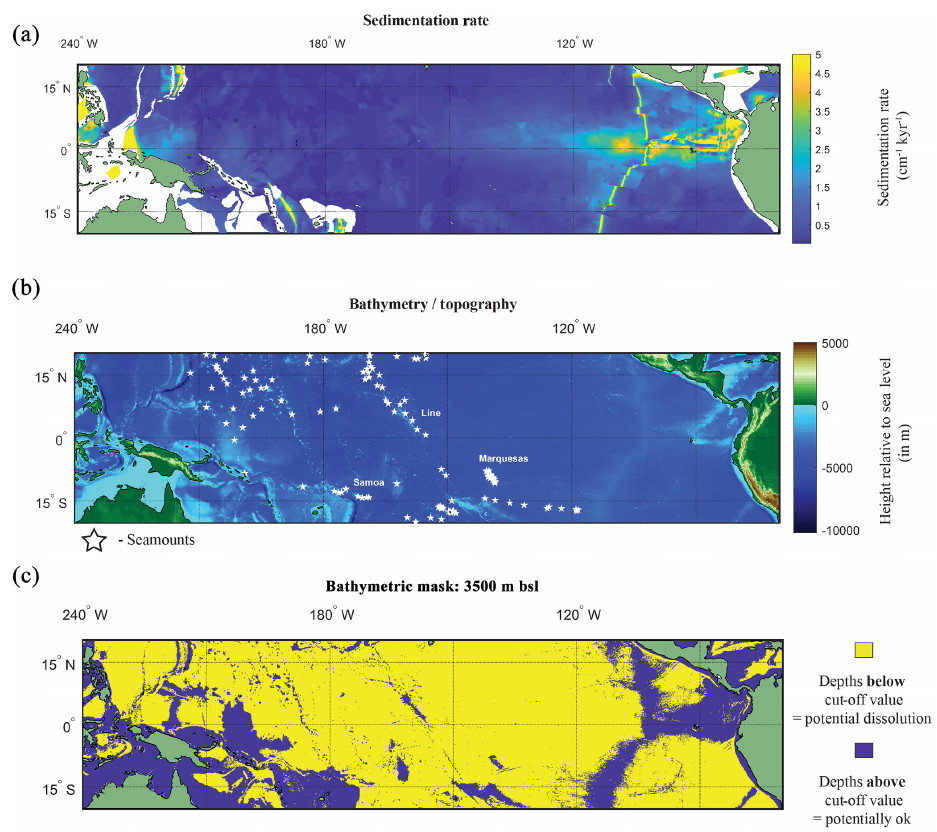
Figure 5. (a) Map of the sedimentation rate and bathymetry of the tropical Pacific. (a) Inferred sedimentation rate (Olson et al., 2016). White regions represent continental shelf. (b) GEBCO map of height relative to 0m with location of seamounts plotted (white stars). (c) A binary colour map of the GEBCO data; yellow is values below cut-off depth value ( > 3500m below sea level – b.s.l.), and purple is above the cut-off depth value. See Fig. S8 for variation in cut-off